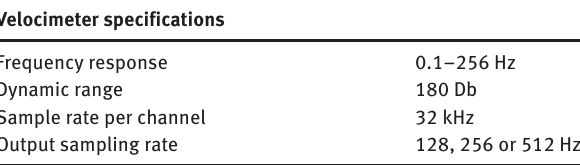
Table 1: Digital velocimeter specifications.